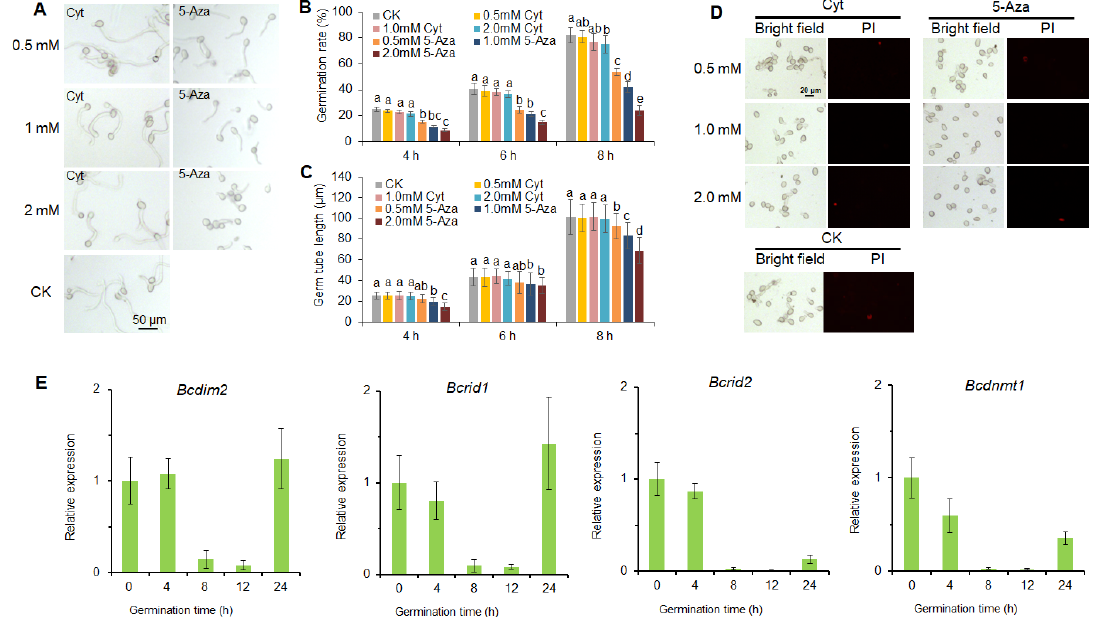
Figure 2. DNA methylation is involved in the development of B. cinerea . ( A ) The effect of 5-azacytidine on conidial germination of B. cinerea . The conidia of B. cinerea were incubated in potato dextrose broth (PDB) medium containing 0.5, 1, and 2 mm 5-azacytidine (5-Aza). Cytidine-treated (Cyt) conidia were used as negative control, and the untreated conidia were used as blank control (CK). ( B ) Conidial germination rate of B. cinerea after treating with 5-Aza and Cyt. ( C ) Germ tube length of B. cinerea after treating with 5-Aza and Cyt. ( D ) Cytotoxicity test of 5-azacytidine on B. cinerea . The conidia were stained with propidium iodide (PI) after treating with 5-azacytinde (5-Aza). Cytidine (Cyt) was used as negative control, and the untreated conidia were used as CK. ( E ) Relative expression of DNA methyltransferase genes during conidial germination of B. cinerea . Vertical bars represent standard errors of the means. Columns with different letters indicate significant differences ( p < 0.05).